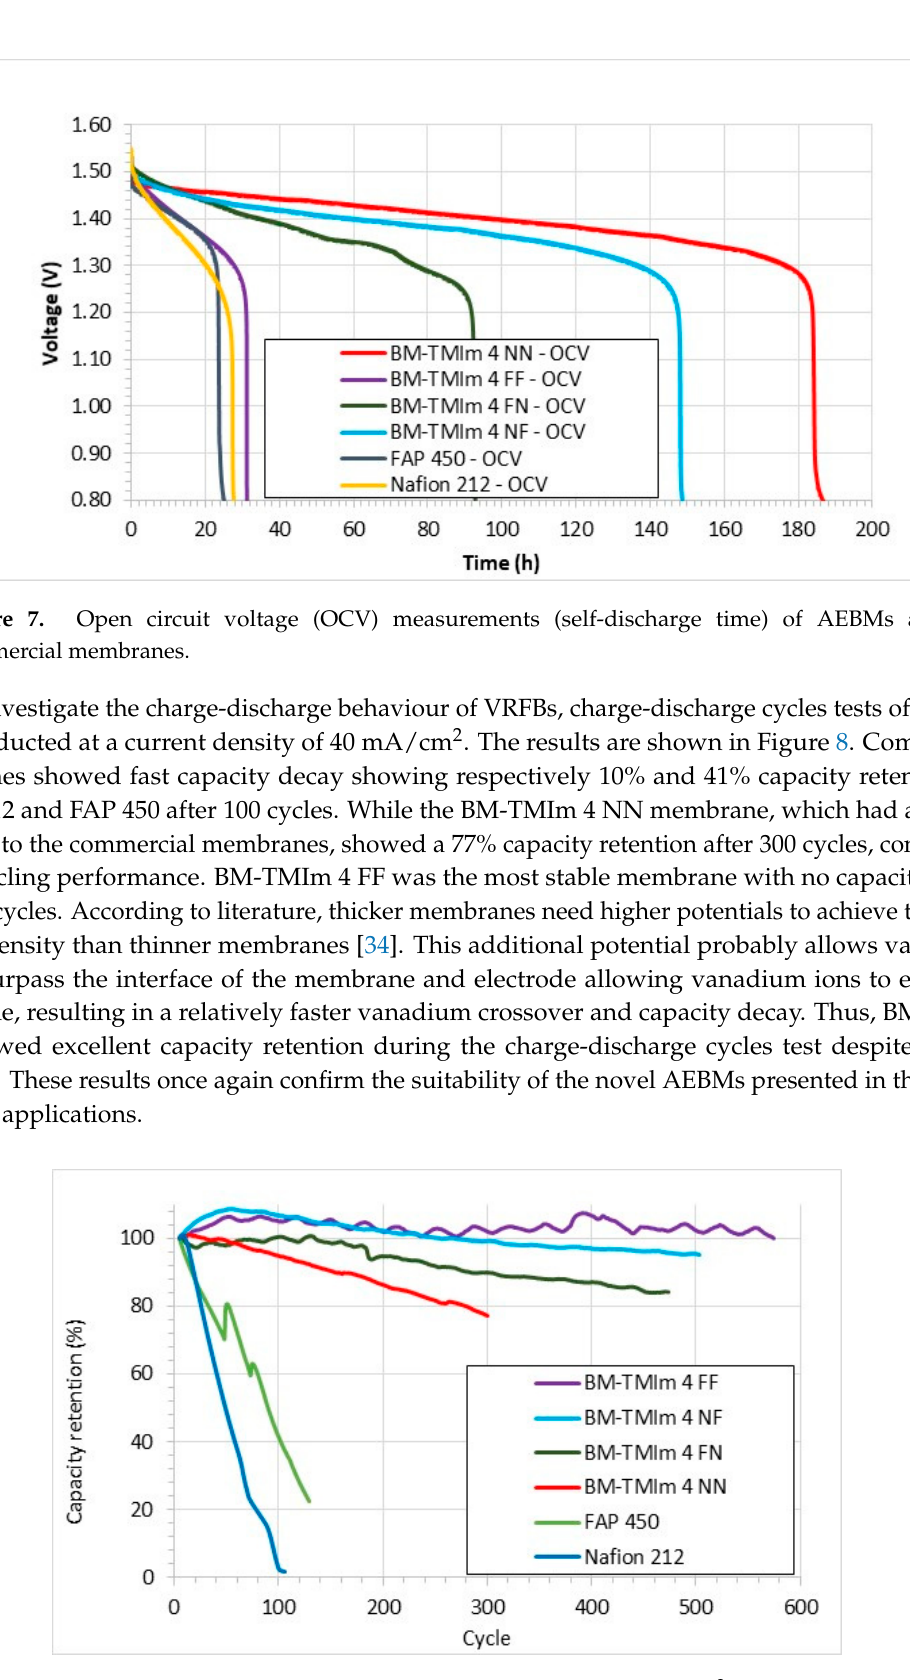
Figure 8. Charge-discharge cycles test run at 40 mA/cm 2 .